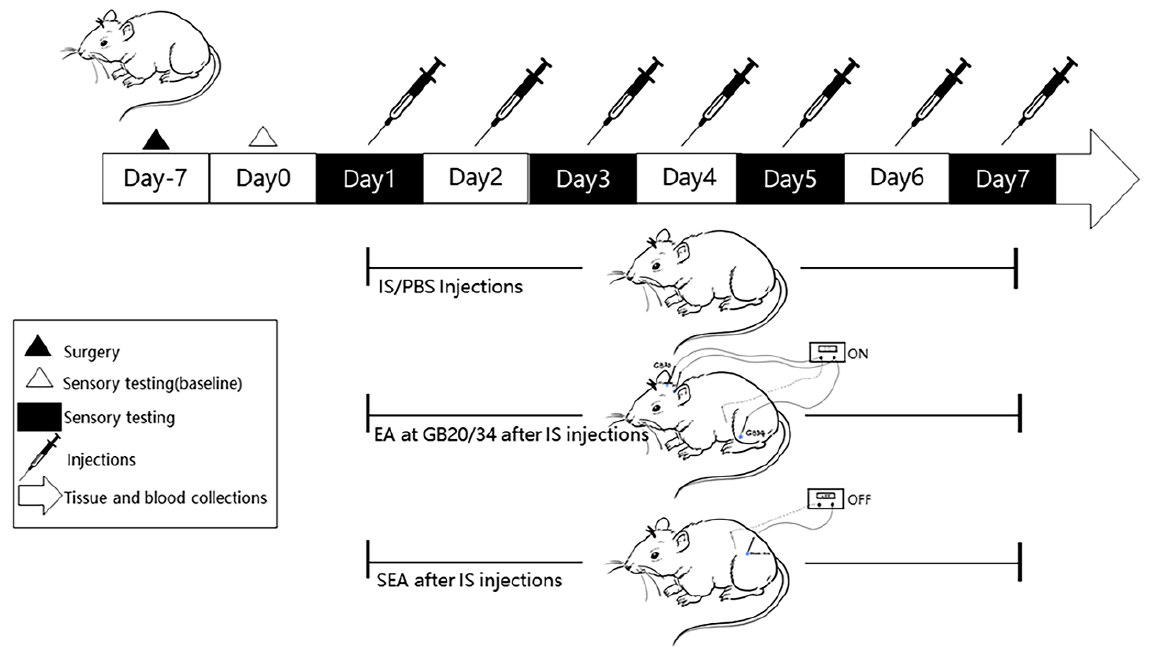
Figure 1. A flow chart of the experimental design. After 7 days of recovery following the implantation of the cannula onto the dura, tactile sensory testing by von-Frey filaments was performed to measure the facial mechanical withdrawal thresholds on day 0 (baseline). Rats received daily repeated-dural IS/PBS (10 ul) injections from day 1 to day 7 for a total of 7 sessions. We set up a blank group without special intervention, except that they were grasped and fixed at the same time (not shown in Figure 1). EA at GB20/GB34 was performed every day after daily IS-dural injection from day 1 to day 7, and SEAs was performed at sham-acupoints without current stimulation at the same time. Facial mechanical threshold was measured at four time points (day 1, day 3, day 5, and day 7) to assess the changes of pain hypersensitivity. The TNC Tissues and blood sample collections were performed after the last intervention.